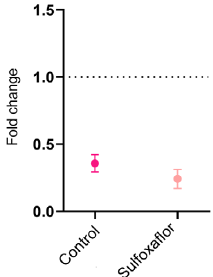
Figure 9. Bee speed fold change pre- versus post-training across treatments in the higher concentration trials ( ± SEM). Fold change calculated by dividing speed post-training by speed pre-training for individual bees. Control n = 9, thiacloprid n = 9, thiamethoxam n = 9, sulfoxaflor n =